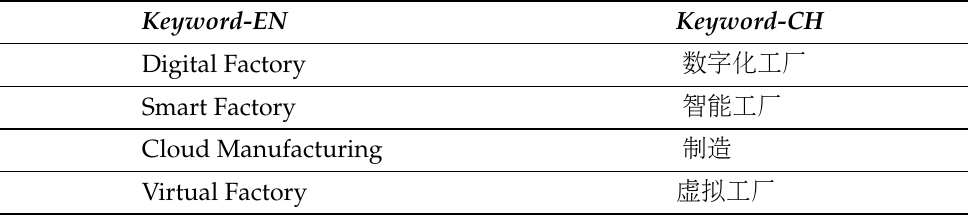
Table 1. Keywords in English and Chinese languages for identification of trends in FoF.